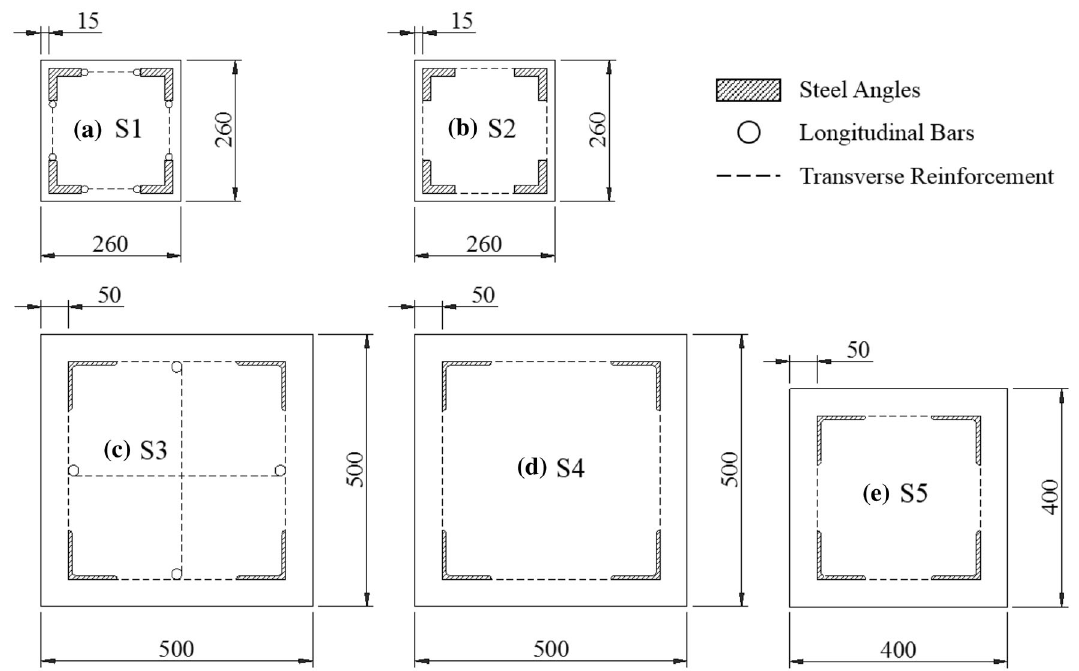
Fig. 2 Section types of previous test specimens (Kim et al. 2014; 2017; Eom et al. 2014; Hwang et al. 2016) [unit: mm].